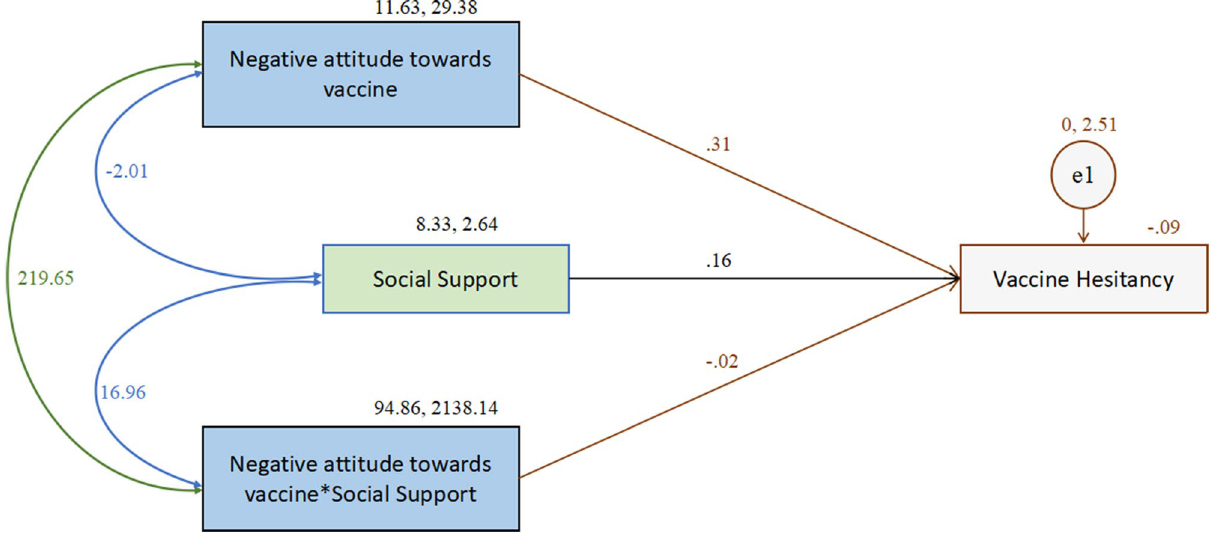
Figure 3. The moderating effect of social support on the relationship between negative attitude towards vaccine and vaccine hesitancy. Path β Stdβ SE p Effect of social support on vaccine